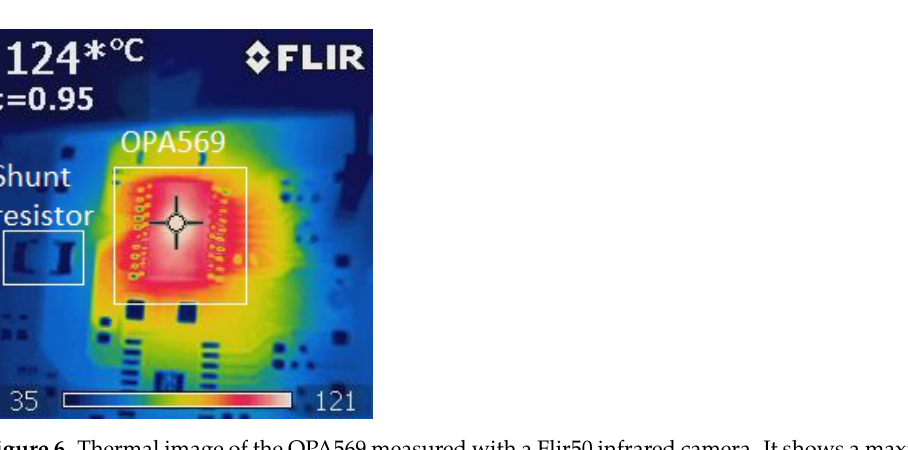
Figure 6. Thermal image of the OPA569 measured with a Flir50 infrared camera. It shows a maximum steady state temperature of 124°C. The measurement was taken after 15min of a constant power (3.37W) stress test.